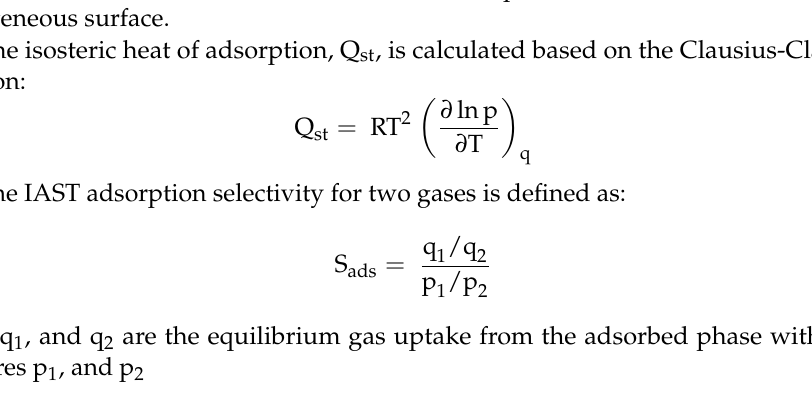
the reaction process, Figure S2: PXRD patterns comparison, Table S1: Langmuir-Freundlich pa- rameters fit for C 2 H 2 , CO 2 , and CH 4 in Zn 2 (Pydc)(Ata) 2 at 298 K, Table S2: Langmuir-Freundlich parameters fit for C 2 H 2 , CO 2 , and CH 4 in Zn 2 (Pydc)(Ata) 2 at 288 K, Table S3: Langmuir-Freundlich parameters fit for C 2 H 2 , CO 2 , and CH 4 in Zn 2 (Pydc)(Ata) 2 at 278